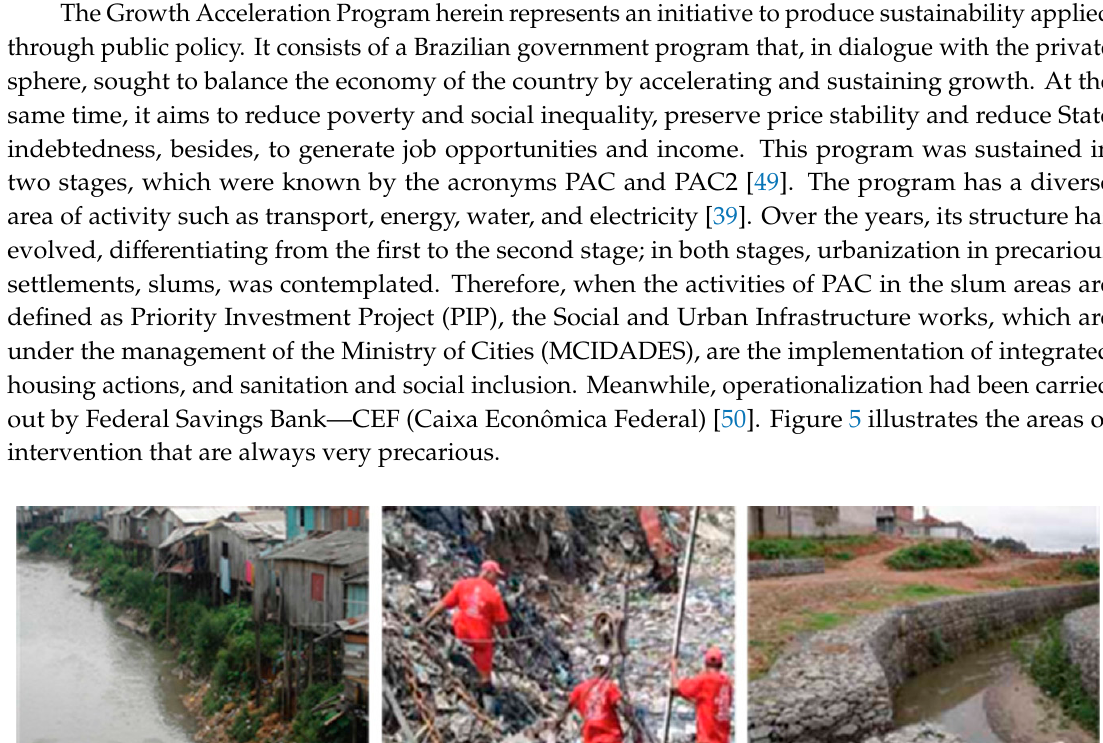
Figure 4. Data collection steps.